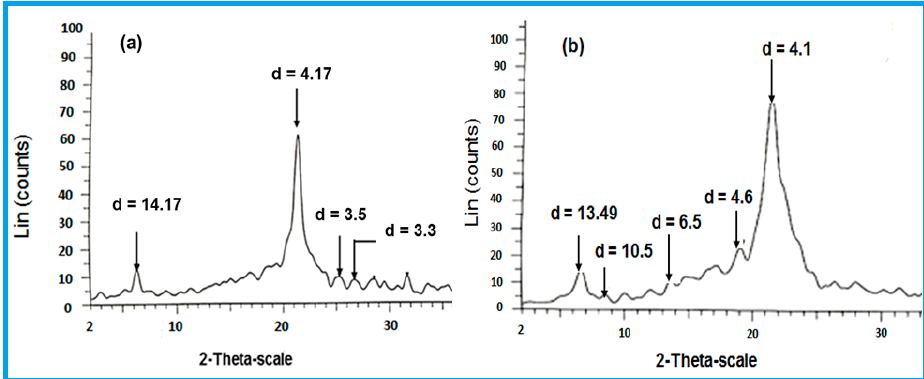
Figure 6. X-ray diffraction spectrum of xerogels of ( a ) thermally-induced gel and ( b ) ultrasound- induced gel.